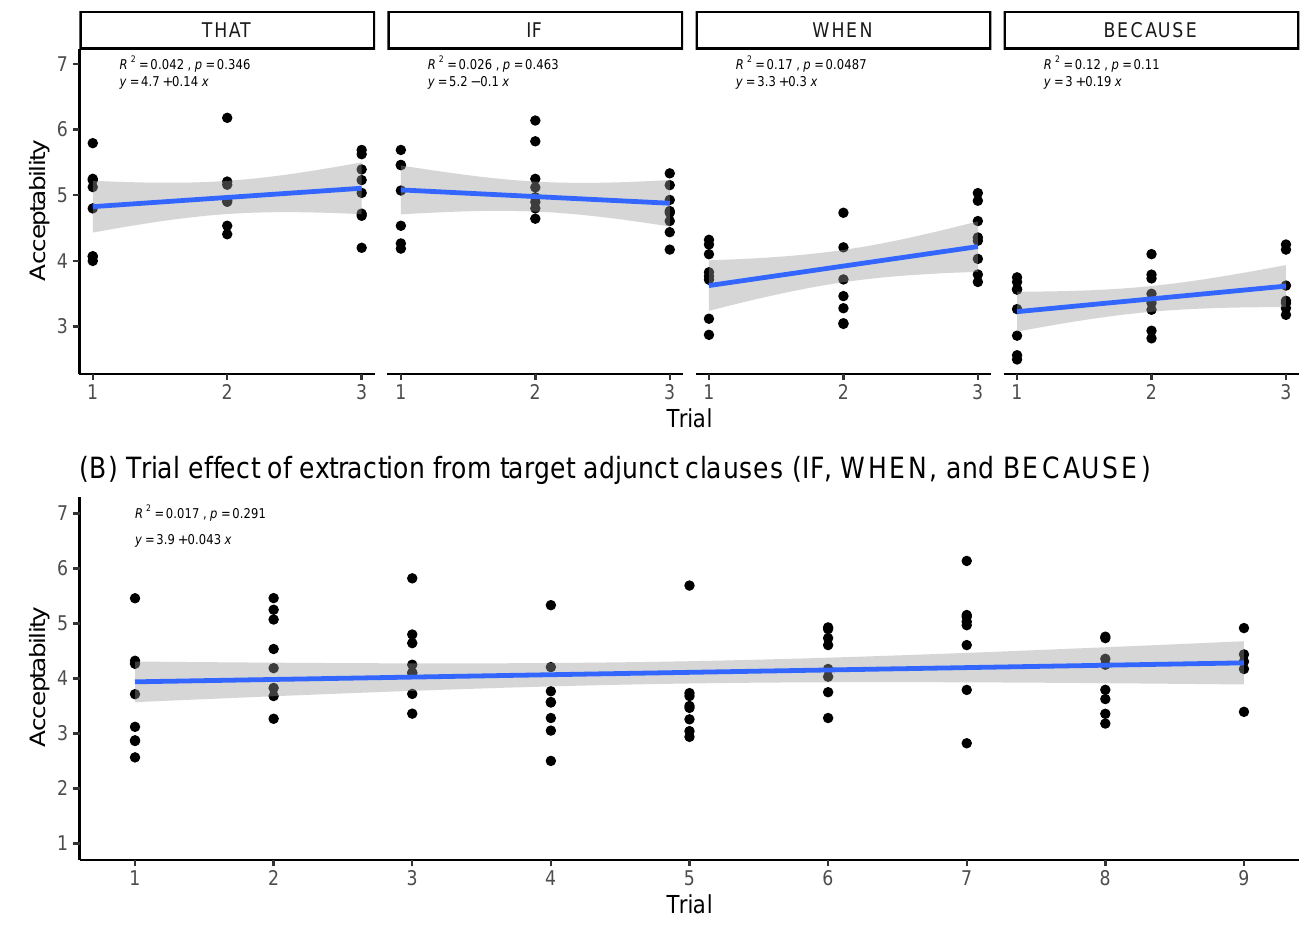
Figure 6. ( A ) Acceptability as a function of repetition (trial) of extractions from complement clauses headed by that and from adjunct clauses headed by if , when and because in the target category. Grey shading: 95% confidence interval. ( B ) Trial effect of extraction from target adjunct clauses headed by either if , when or because . Grey shading: 95% confidence